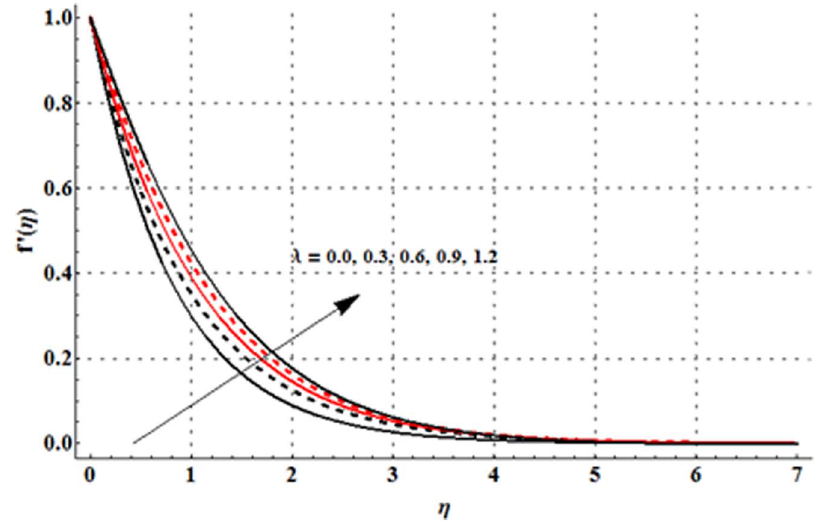
Figure 6. Influence of l on the velocity profile f ’ ( g ) when M ~ 0 : 6, b ~ 0 : 4 ~ Rd , l 1 ~ 0 : 5, N ~ 0 : 3, Pr ~ 1 : 2, S ~ 0 : 2 ~ S (cid:2) and Sc ~ 1 : 0 :